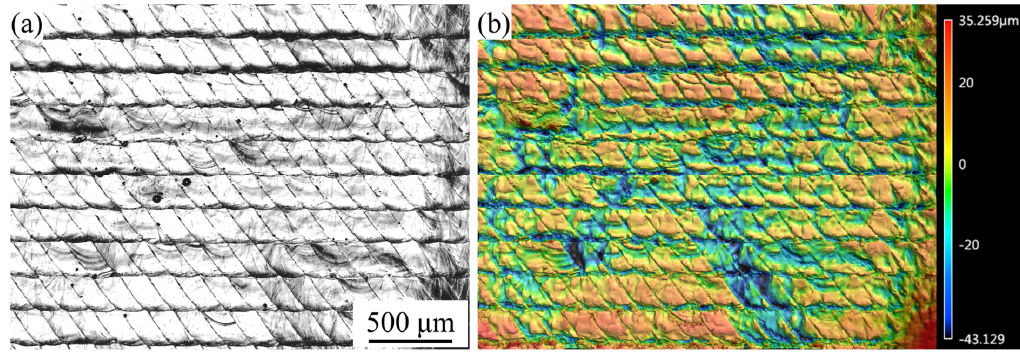
Figure 8. Surface topography: ( a ) OM, ( b ) 3D topography.